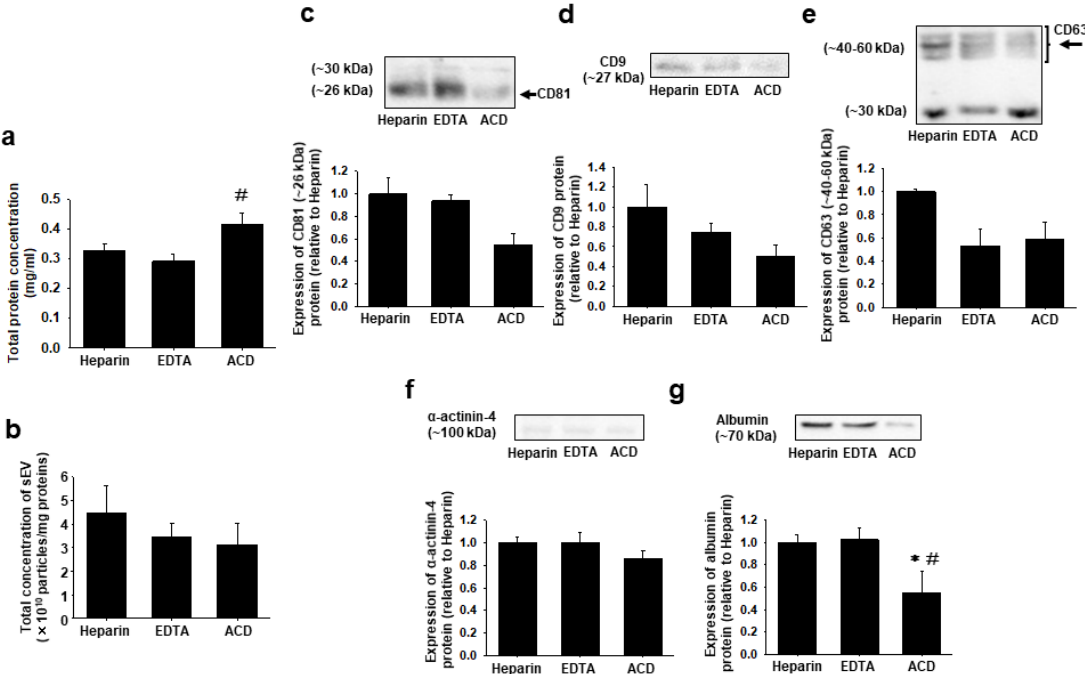
Figure 5. Effects of anticoagulants on total protein concentration and expression of marker proteins for sEVs, large EV, or plasma in sEVs. Total protein was extracted from sEVs isolated from heparin (1 U/mL)-, EDTA (1 mg/mL)-, or ACD (13%)-anticoagulated plasma in Wistar rats (5–10-week-old) by the PEG-UC method using RIPA buffer. ( a ) The concentration of proteins was measured by a BCA assay and normalized to the starting volume of plasma (mg/mL). ( b ) The total concentration of plasma sEVs normalized to each protein concentration was shown (particles/mg). ( c – g ) Expression of marker proteins was determined by Western blotting using antibody to CD81, CD9, CD63, α-actinin-4, or albumin. The arrows indicated the bands for CD81 (c) and CD63 (e) that we measured for quantitative analyses. Data were shown as fold increase relative to the expression level in sEVs derived from the heparin-anticoagulated plasma. Results were expressed as means ± SEM in bar graphs ( n = 4). Uncropped images are shown in Supplementary Figure S3. * p < 0.05 vs. heparin, # p < 0.05 vs. EDTA.